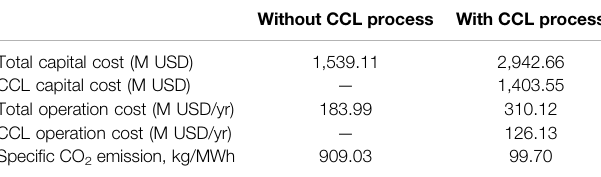
TABLE 6 | Economics of the referenced plant with and without the CCL